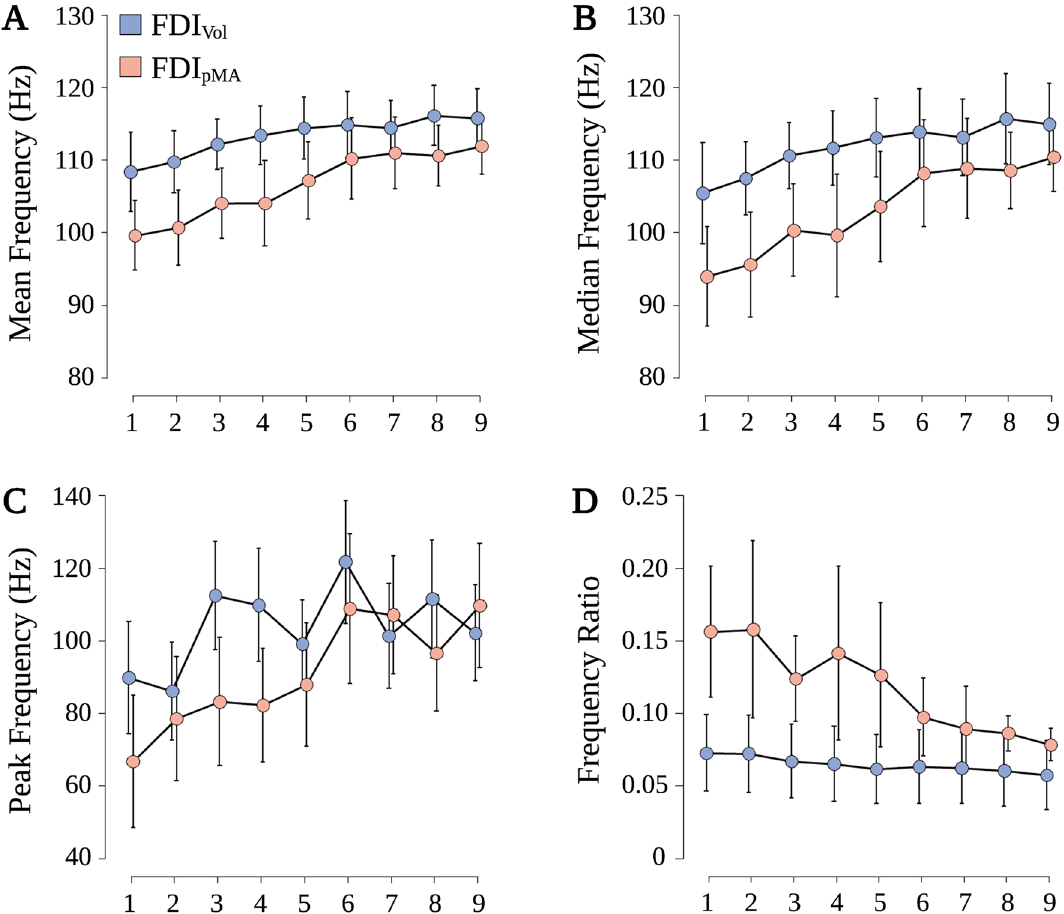
Figure 3. Frequency features of FDI Vol and FDI pMA . ( A ) Blockwise mean frequency (MNF). ( B ) Blockwise median frequency (MDF). ( C ) Blockwise peak frequency (PKF) corresponding to the frequency of the maximum energy of the power spectrum. ( D ) Blockwise frequency ratio (FR), calculated as a ratio between low- and high-frequency content of the sEMG signals with a cutoff frequency of 40 Hz. Values are displayed as mean ± 95% confidence